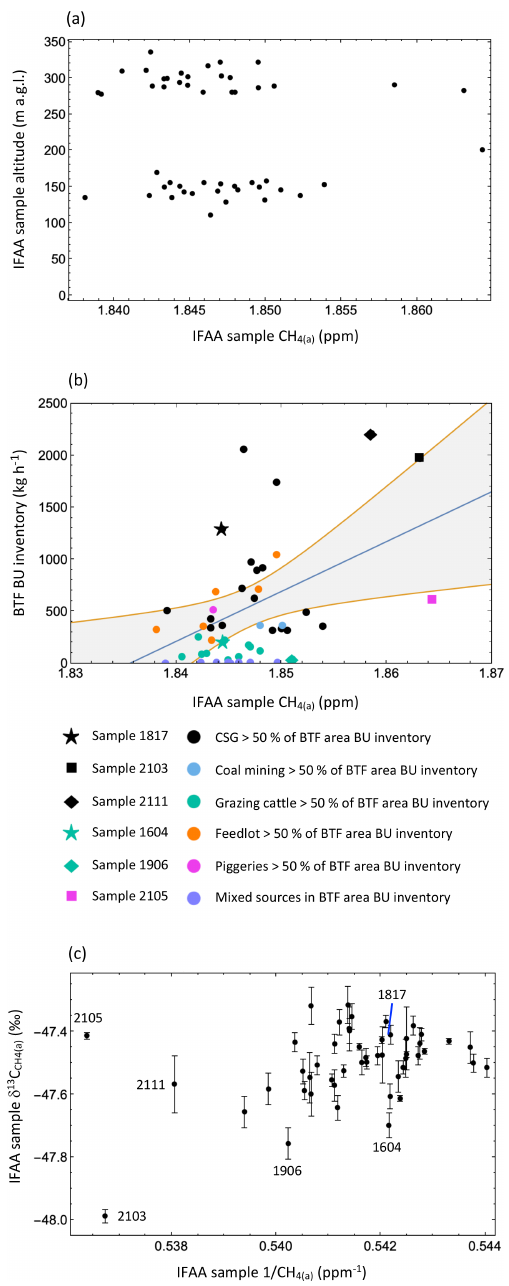
Figure 3. IFAA sample observations between altitudes 100– 350ma.g.l. (a) IFAA sample altitude (ma.g.l.) versus IFAA sample CH 4(a) (ppm). This plot highlights the sampling at altitudes of ap- proximately 150 and 300m. (b) Back-trajectory footprint bottom– up (BTF BU) inventory CH 4 (kgh − 1 ) versus IFAA sample CH 4(a) (ppm). The linear regression fit highlights the moderate correlation ( R 2 = 0 . 59) between the two variables. The grey zone is the 95% confidence level. (c) A Keeling plot: IFAA samples δ 13 C CH sus IFAA sample 1/CH 4(a) (ppm). (The error bars are 1 standard deviation. For 1/CH 4(a) the errors are too small to be observable; IFAA samples 1604, 1817, 1906, 2103, and 2105 are discussed in detail in the main